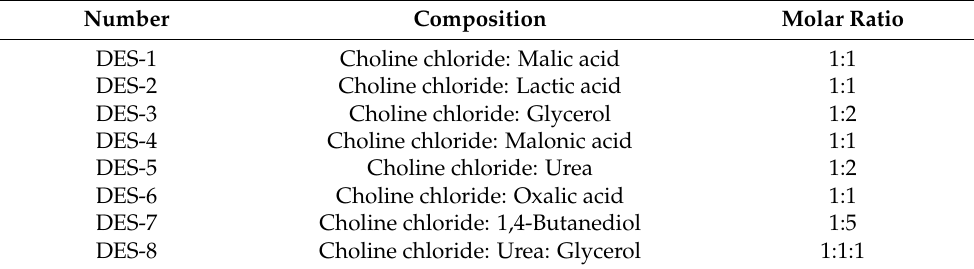
Table 3. Composition of